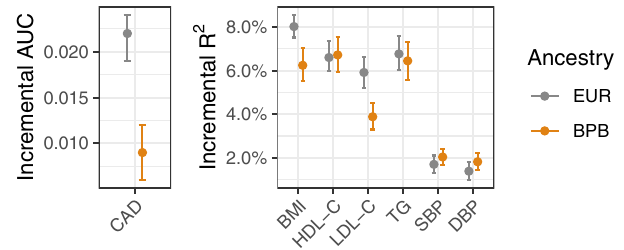
Fig. 3 | Comparison ofthe predictive accuracy ofpolygenic scores in peopleof British Pakistani and Bangladeshi versus European ancestry. Incremental AUC isshownforcoronaryarterydisease(CAD; n =17,348and32,816unrelatedsamples from G&H and eMERGE, respectively) and Incremental R 2 is shown for its con- tinuous risk factors, namely body-mass index (BMI; n =13,926 and 37,160), high- density lipoprotein cholesterol (HDL-C; n =11,316 and 16,049), low-density lipo- protein cholesterol (LDL-C; n =12,856 and 15,856), triglycerides (TG; n =11,125 and 14,384), systolic blood pressure (SBP), and diastolic blood pressure (DBP; n =15,908 and 11,864 for blood pressure). Grey indicates European-ancestry (EUR) individuals from eMERGE and orange British Pakistani and Bangladeshi (BPB) individuals from G&H. Error bars represent 95% con fi dence intervals estimated by bootstrap resampling of samples. The highest measurements for LDL-C, SBP, and DBP are compared between eMERGE and